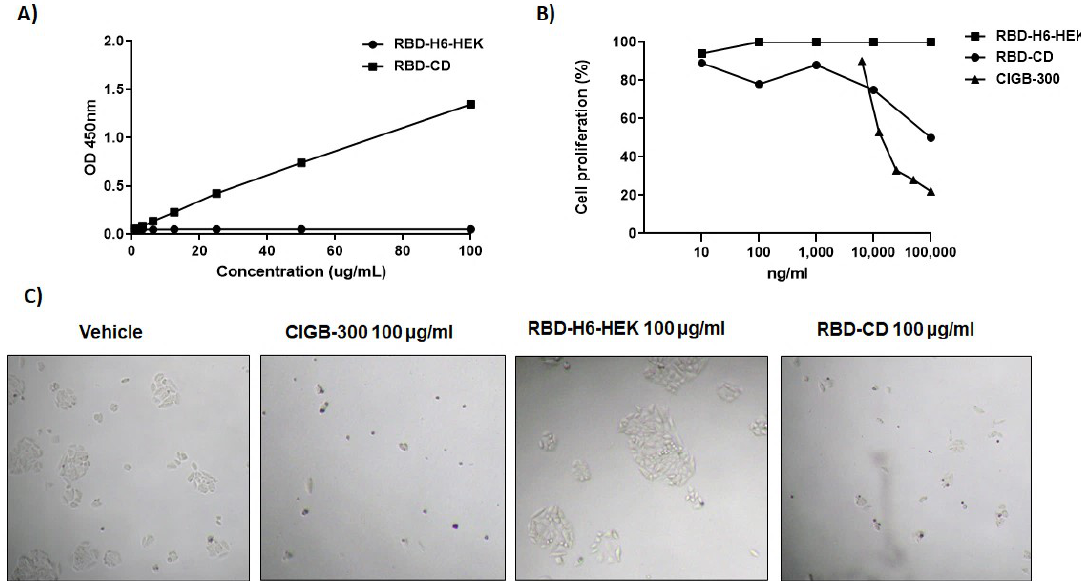
Figure 6. CD40 binding and signaling activation in vitro. ( A ) Binding ELISA using human Fc-CD40 as coating antigen. ( B ) Effect of RBD-CD on cell growth of NCI-H460 cells using crystal violet staining. The lung cancer cell line was cultured for 72 h with increasing concentrations of RBD-CD, RBD-H6- HEK, and CIGB-300. ( C ) Antiproliferative effect of RBD-CD in the lung cancer cells NCI-H460 using light microscopy (magnification 10 × ).